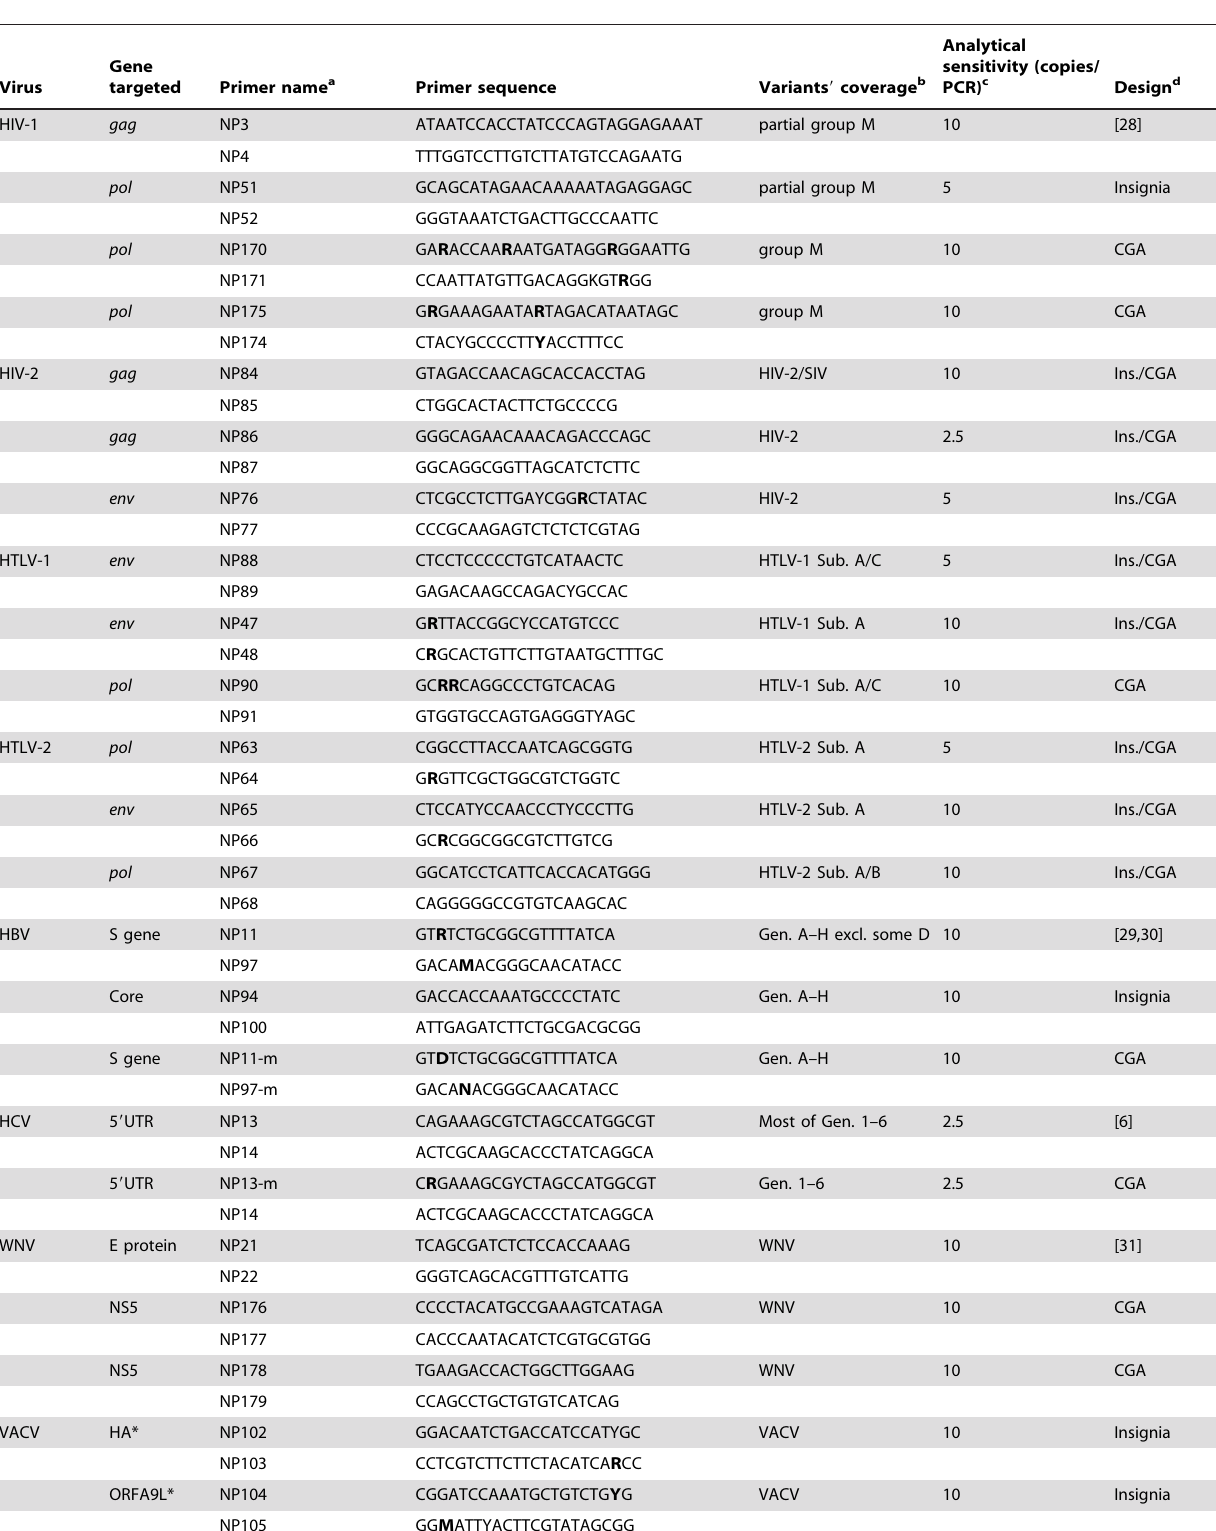
Table 1. List of primers selected for the real-time PCR array based on their specificity and sensitivity with in-house analytical